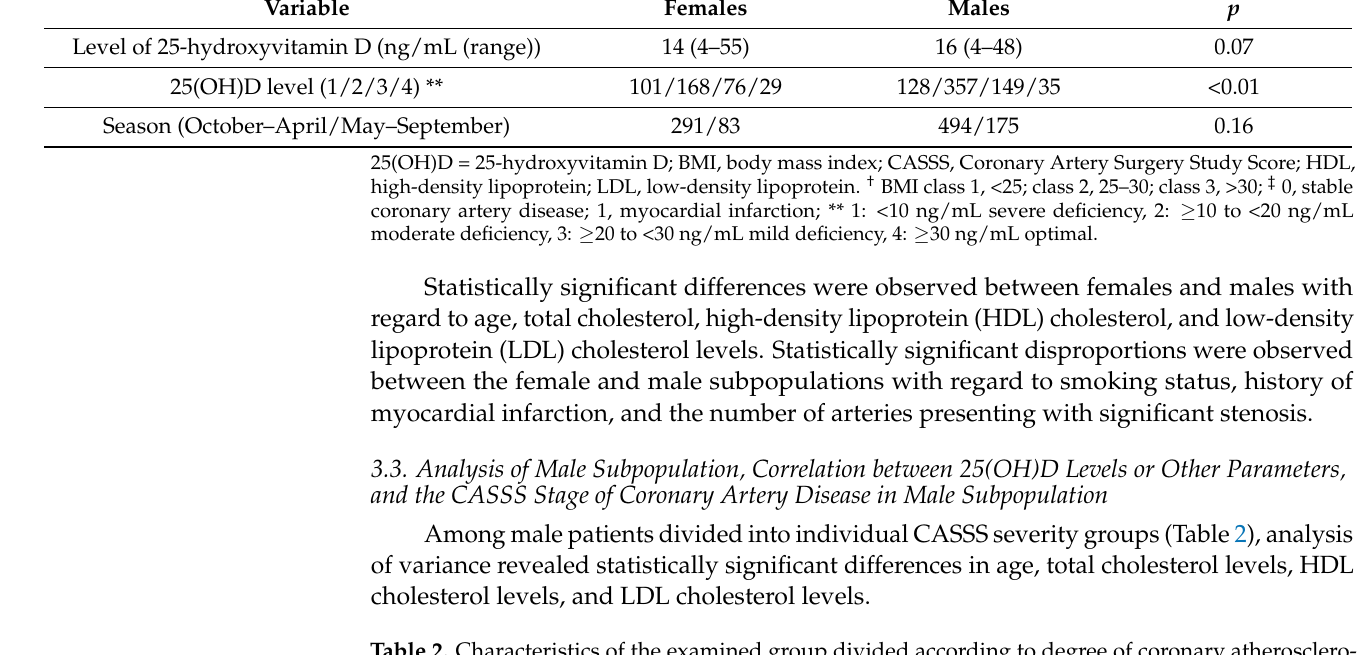
Table 2. Characteristics of the examined group divided according to degree of coronary atherosclero- sis (the Coronary Artery Surgery Study Score (CASSS)) into four